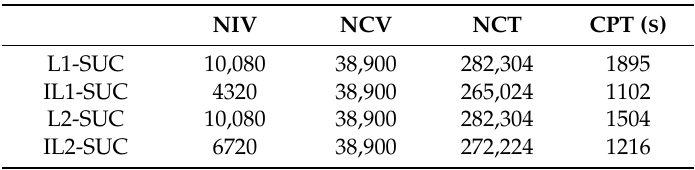
Table 11. Computational performance for improved L-SUC